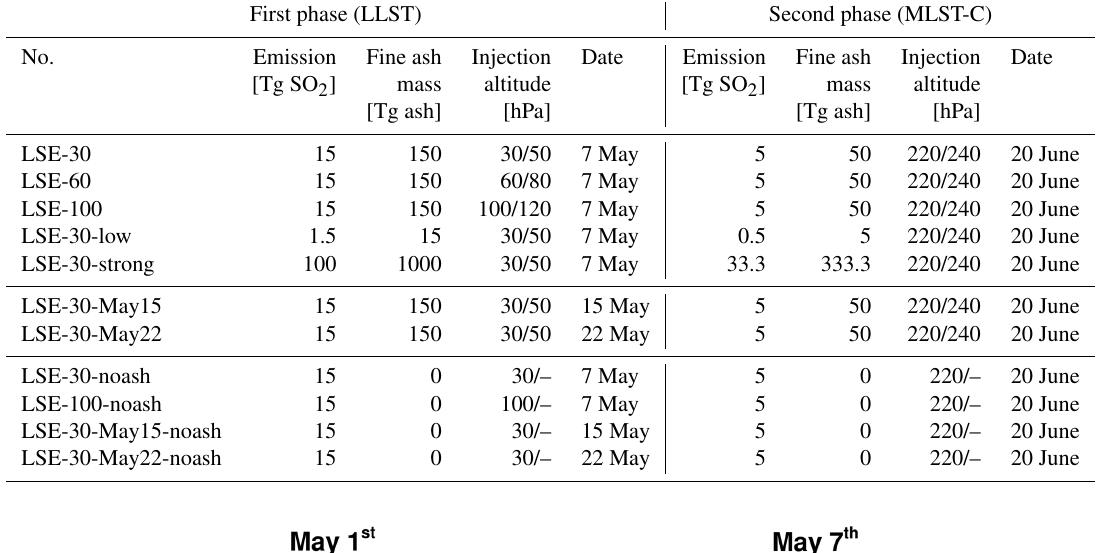
Table 1. Overview of the different LSE-type simulations. The emitted mass of the second eruption is one-third of the first eruption for SO 2 and ash, respectively. The first number of the injection altitude is the altitude of the SO 2 injection; the second is the altitude of the ash injection. The duration of the first phase (LLST) was assumed to be 10h and the second phase (MLST-C) 3h.